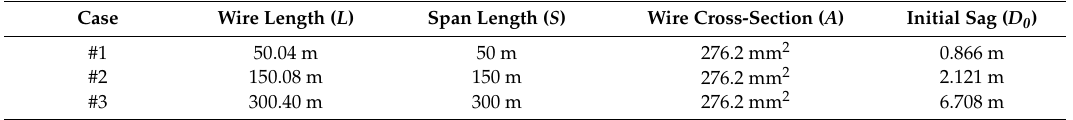
Table 1. Parameters of tested spans.